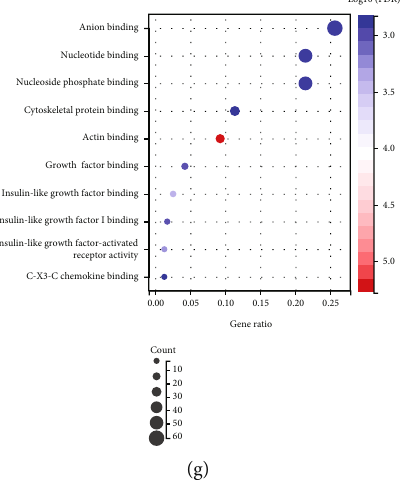
Figure 3: Clinical feature and WGCNA selection of the cluster-related genes. (a) The di ff erences in clinical features between clusters C1 and C2. (b) Comparison of the GDSC compound IC50 of three drugs between clusters. (c) Correlation heat map of the WGCNA module- phenotype correlation (left) and the scatter plot showing the correlation between gene signi fi cance and module membership (right). Functional enrichment analyses of the KEGG (d), GO biological process (e), cellular component (f), and molecular function (g) gene